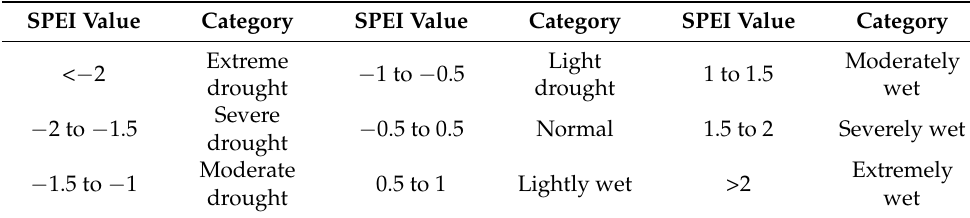
Table 1. Categorization according to the SPEI